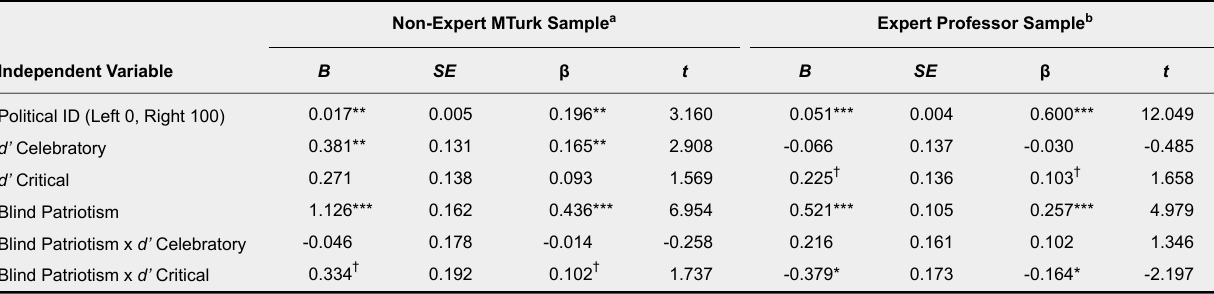
Expert Professor Sample b Non-Expert MTurk Sample a